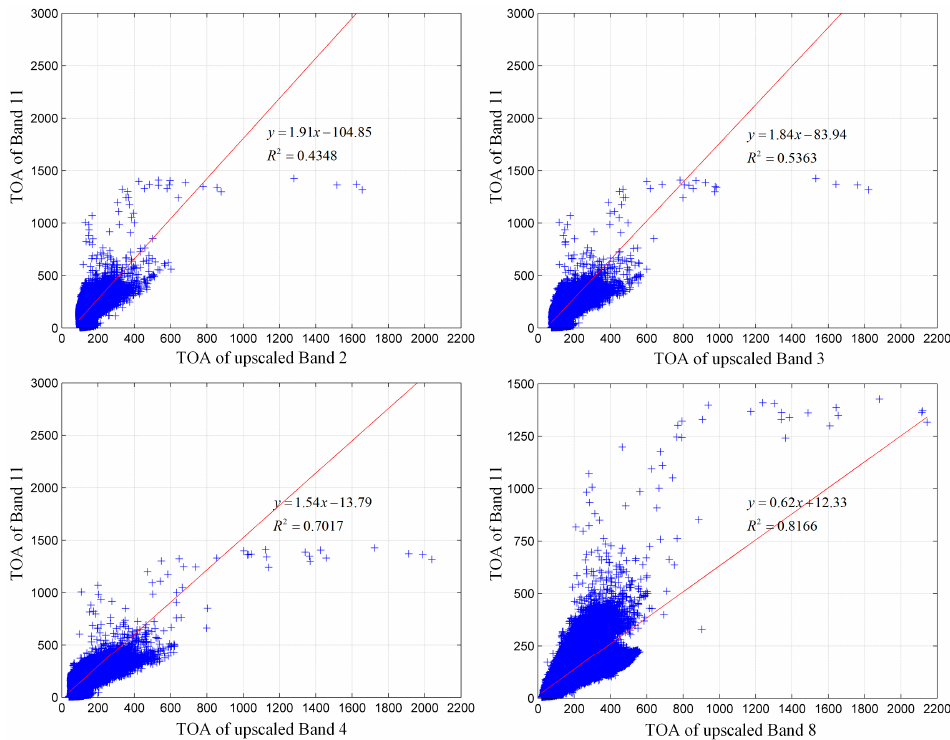
Figure 3. Scatter maps and correlation coefficients between 20-m SWIR band and the four upscaled Bands 2, 3, 4 and 8 of Sentinel-2. D indexes of the sharpened SWIR band and Band 8A generated by PCA, Table 3. QNR, D λ and s